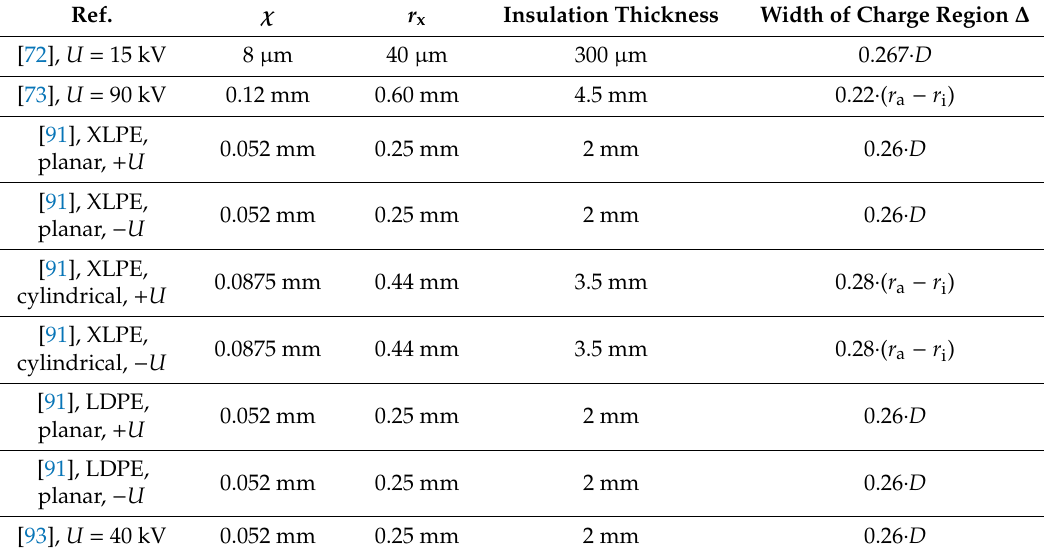
Table 2. Distance constant χ and position r x for the simulation of space charge measurements in [72,73,91,93]. The absolute value of the applied voltage is | U | = 20 kV.